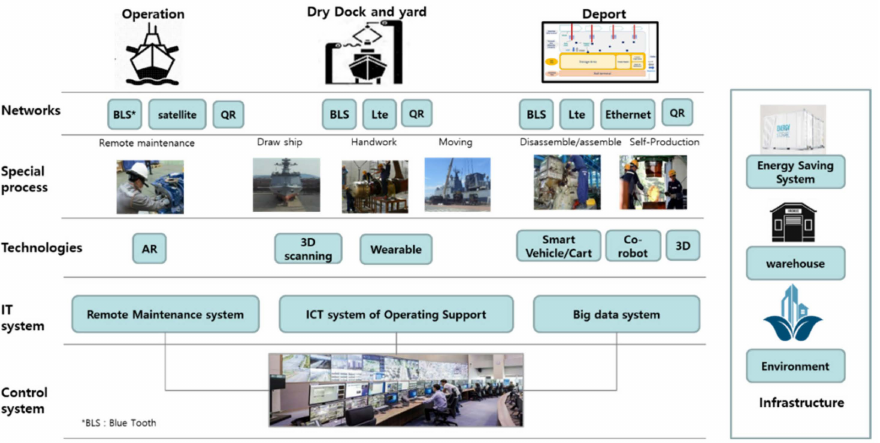
Figure 9. Future image of a transformed smart